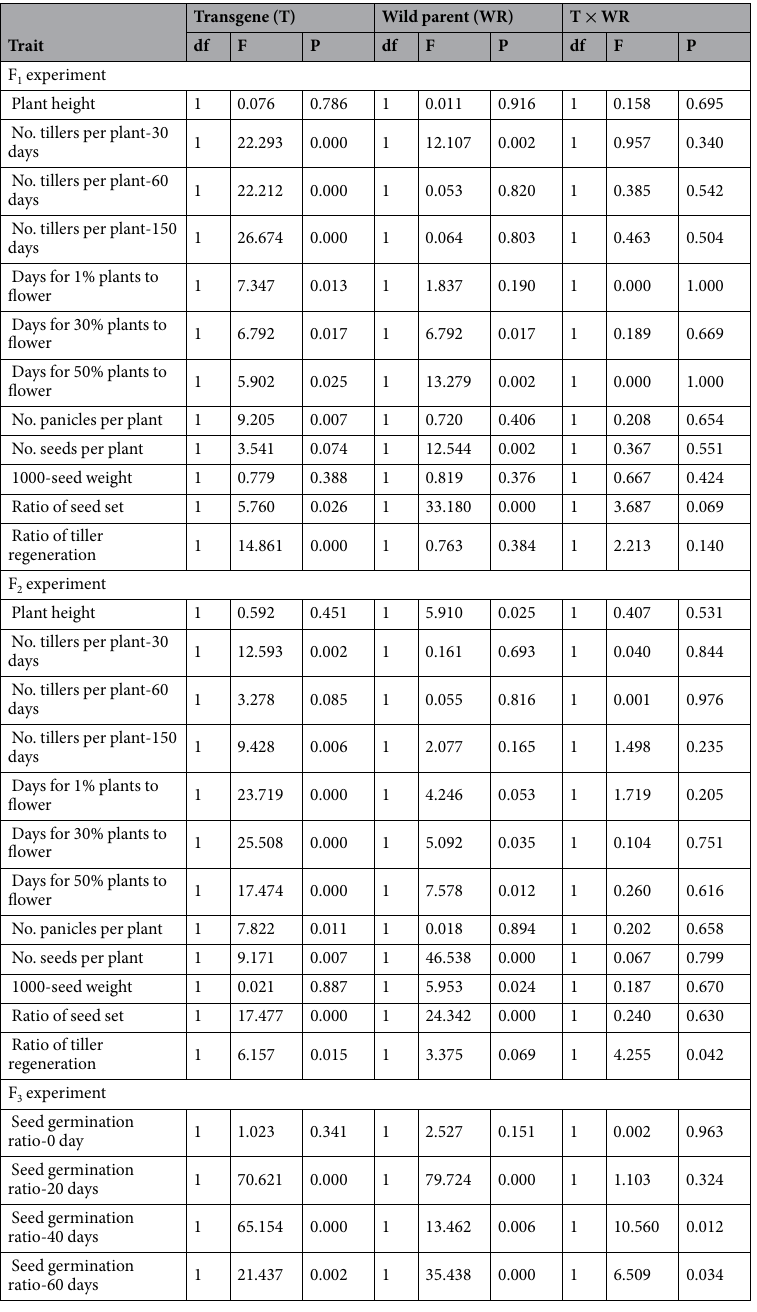
Table 1. Two-way ANOVAs for the effects of transgene (transgenic vs . non-transgenic), wild parent (WR1 vs . WR2), and their interactions on life-cycle fitness related traits of F 1 -F 3 rice crop-wild hybrid descendants. Df, degree of freedom; F, F values; P, level of